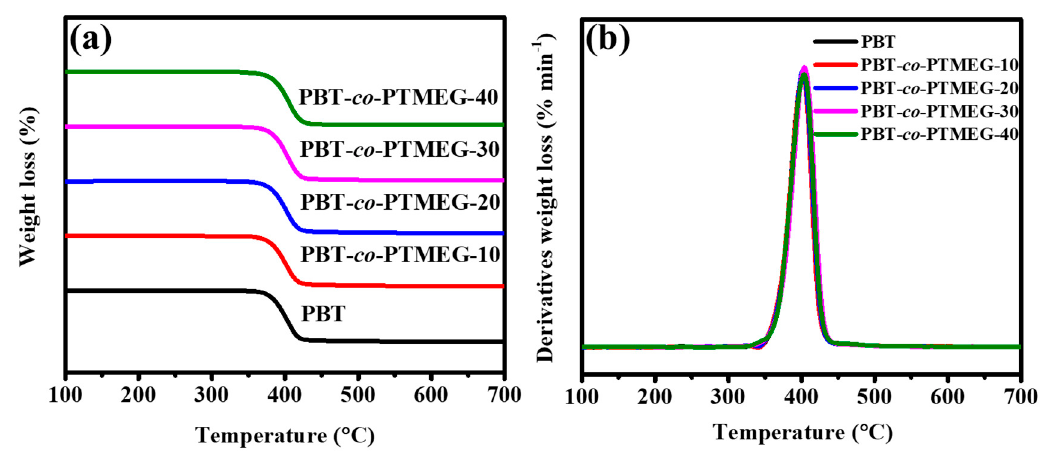
Figure 4. (a) Weight loss and ( b ) derivative thermogravimetry (DTG) as a function of temperature for PBT and PBT- co -PTMEG copolymers.